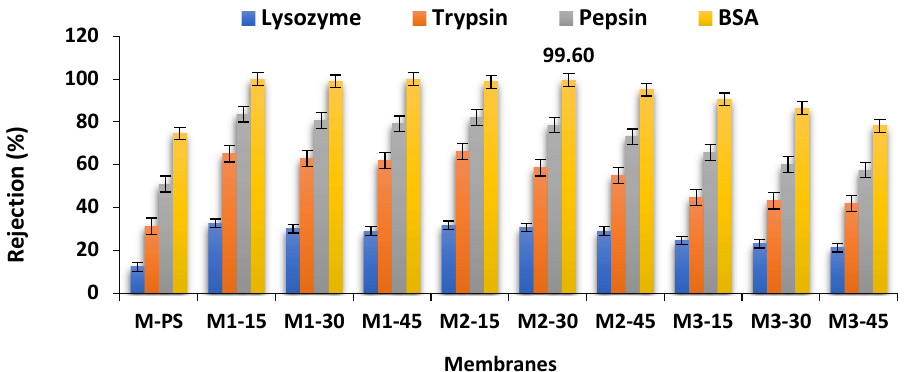
Figure 14. Separation performance of membranes in removing BSA, pepsin, trypsin and lysozyme using feed solution containing 1000 ppm solute ( n = 3).